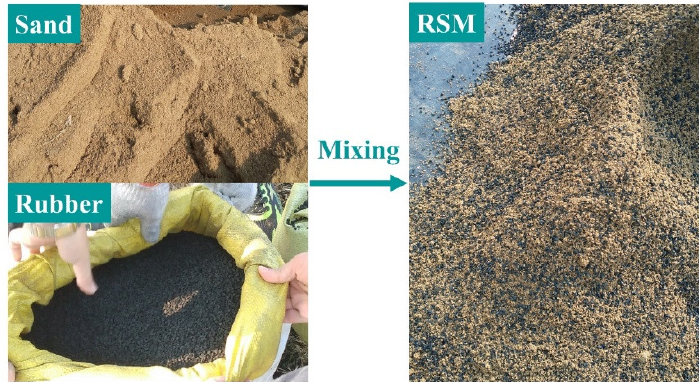
Figure 9. Cumulative gradation curve.